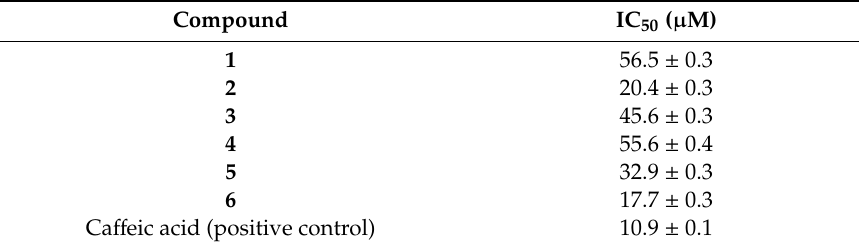
Table 4. Radical-scavenging activity (assessed against DPPH) of compounds 1 – 6